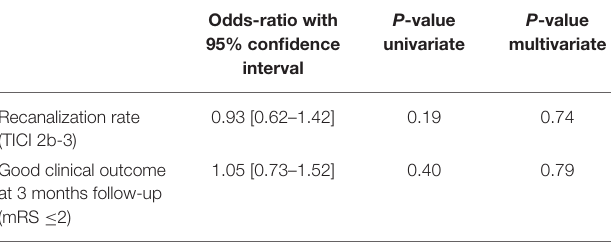
TABLE 4 | Results of multivariate analysis: Odds ratio for recanalization success and good clinical outcome among patients who underwent gadolinium-enhanced extracranial MRA prior to